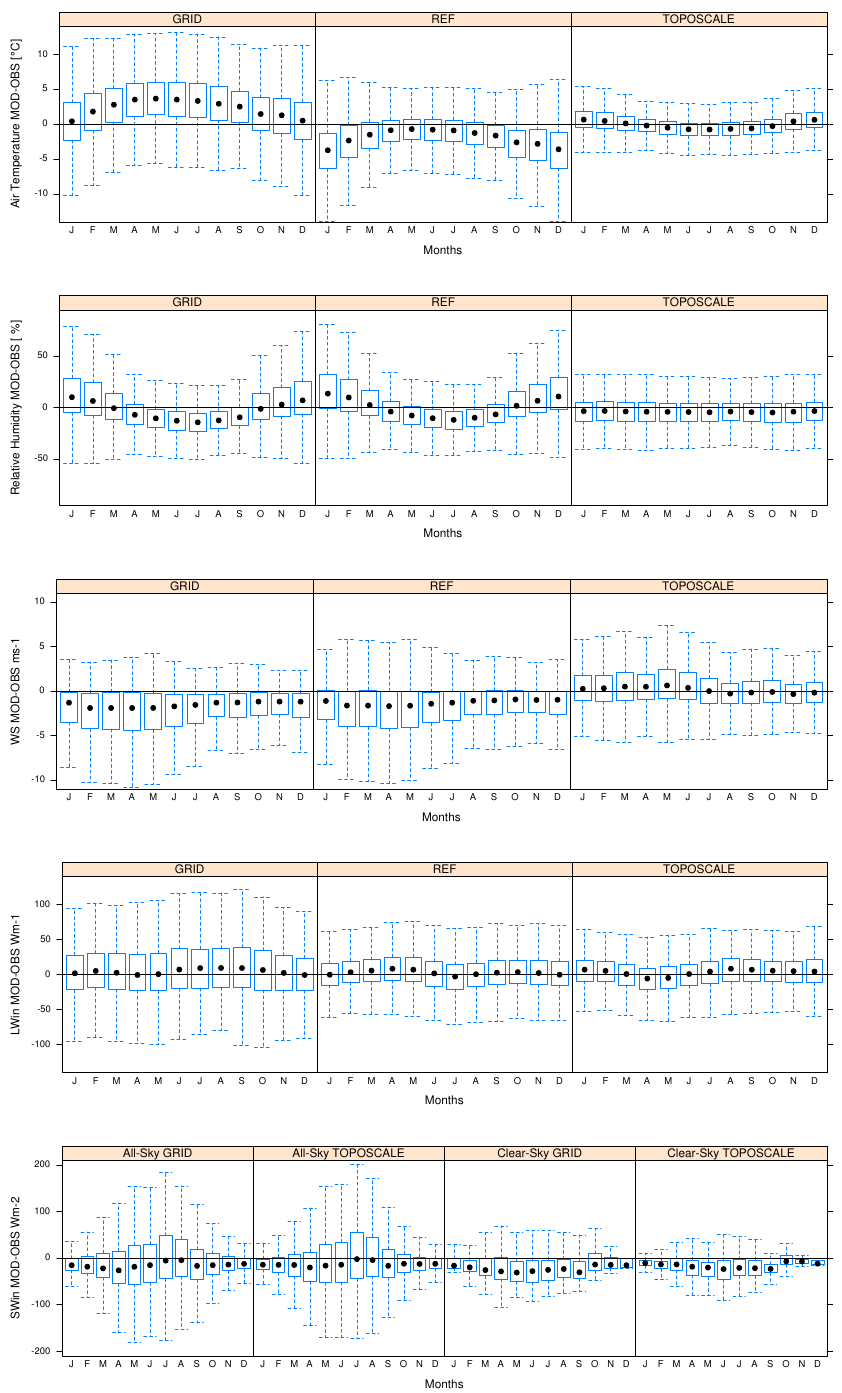
Fig. 11. Boxplots of deviation of daily values of MOD from OBS, for downscaled variables, grouped according to month of the year in order to investigate seasonal patterns in the error